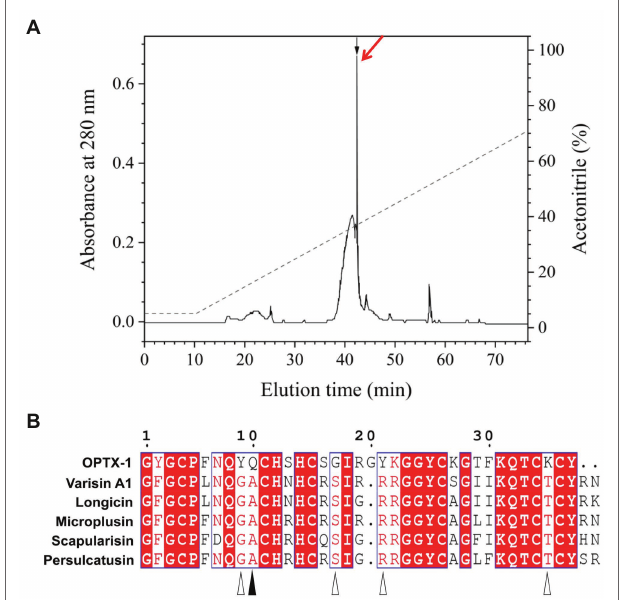
FIGURE 1 | Refolding of OPTX-1 and the sequence alignment with its analogs. (A) OPTX-1 folded into the correct structure was collected by analysis chromatography, which was purified using a RP-HPLC column (Unisil C18 column, 5 μ m particle size and 10 × 250 mm). Elution was performed at a flow rate of 1.5 ml/min with the indicated gradients of acetonitrile in 0.1% (v/v) trifluoroacetic acid (TFA) in water. (B) Similarity of OPTX-1 to hard tick-derived defensins. The relevant sequence GenBank accession numbers are: OPTX-1: FJ222575.1, Varisin A1: AY181027.1, longicin: EU035973.1, Microplusin: MK818522.1, Scapularisin: AY660970.1, Persulcatusin: